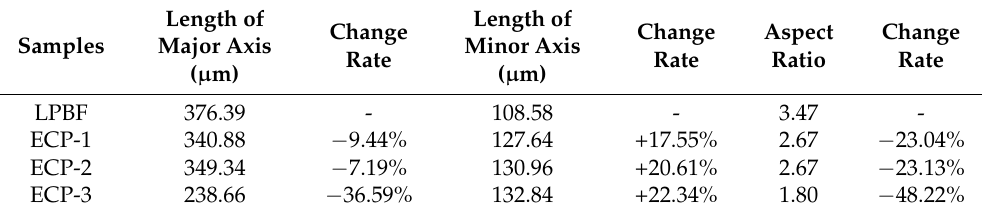
Figure 3. OM micrographs of the LPBF-Ti64 samples in the parallel building direction before and after ECP treatment: ( a ) LPBF, ( b ) ECP-1, ( c ) ECP-2 and ( d ) ECP-3. Table 4. The length of major axis, the length of minor axis, the aspect ratio, and the corresponding change rate of the prior β grains in the LPBF-Ti64 samples in the parallel building direction before and after ECP treatment.